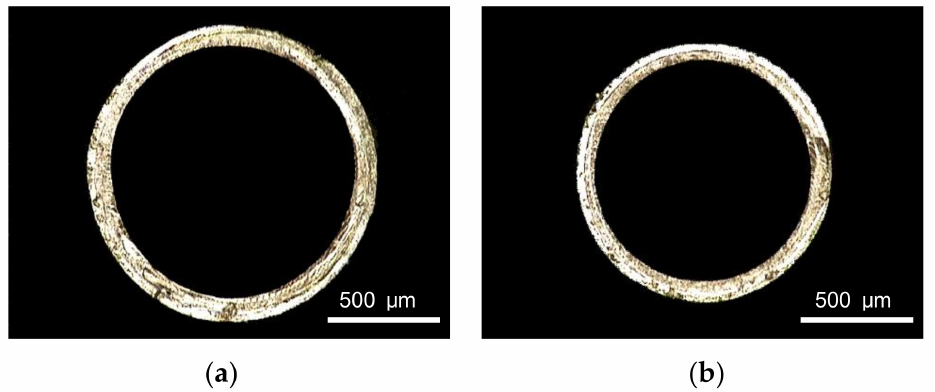
Figure 10. Cross section of micro tubes at different pulling speeds: ( a ) Pulling speed = 7 m/min; ( b ) Pulling speed = 12